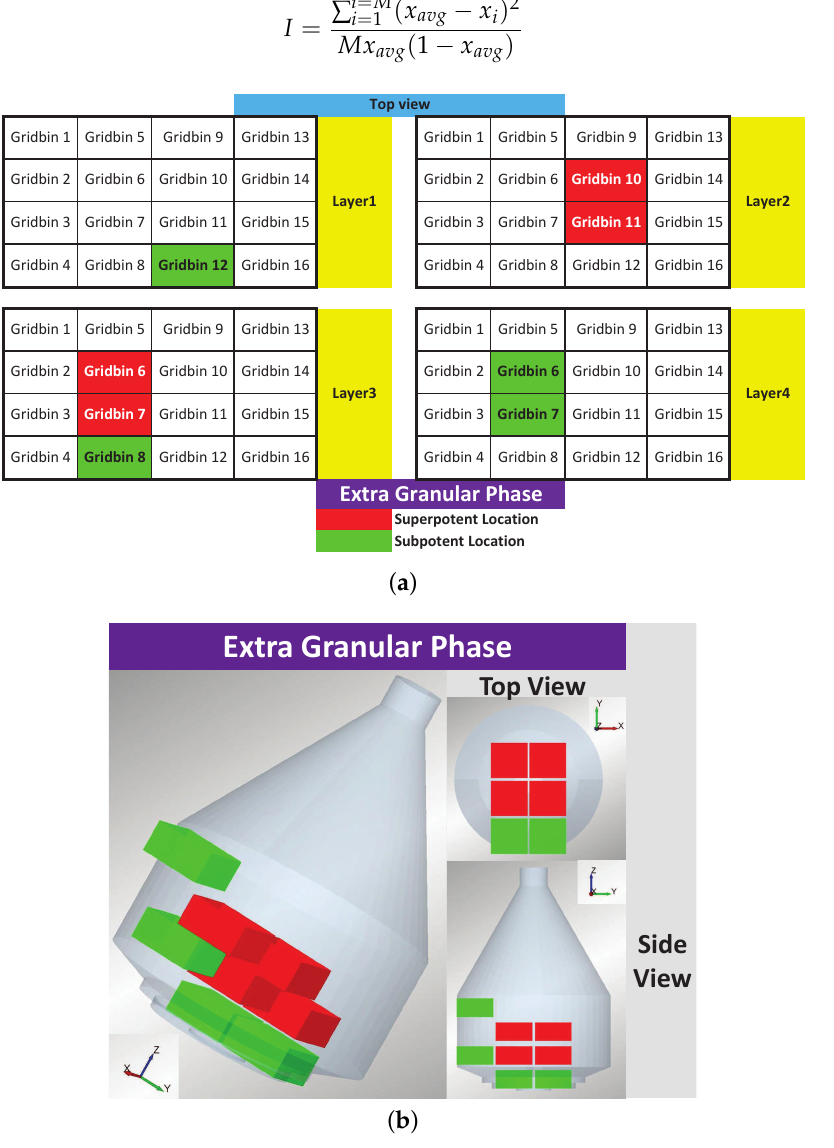
Figure 8. Super-potent and sub-potent regions in the mixing of the extra granular phase represented as: ( a ) the Cartesian system; ( b ) 3D